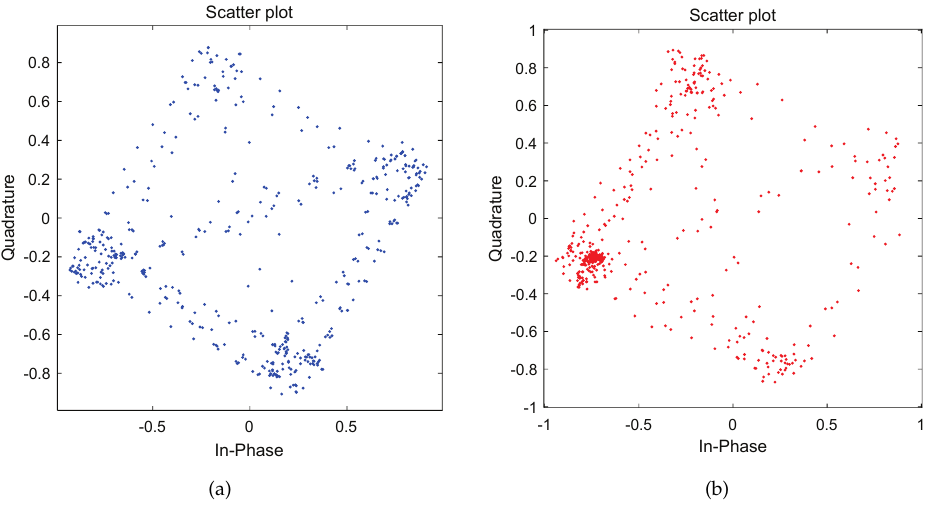
Figure 5. A comparison between the constellation diagrams of ( a ) legitimate and ( b ) spoofing QPSK